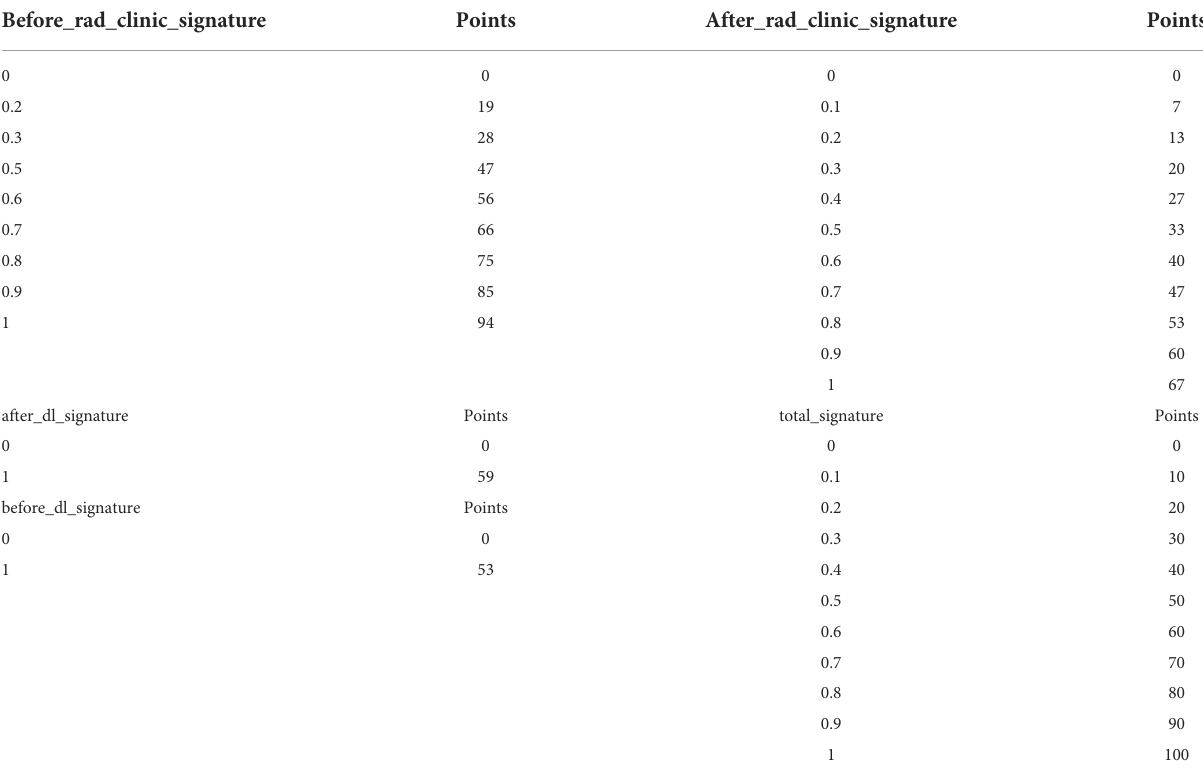
TABLE 19 The features in the nomogram and the corresponding scores.